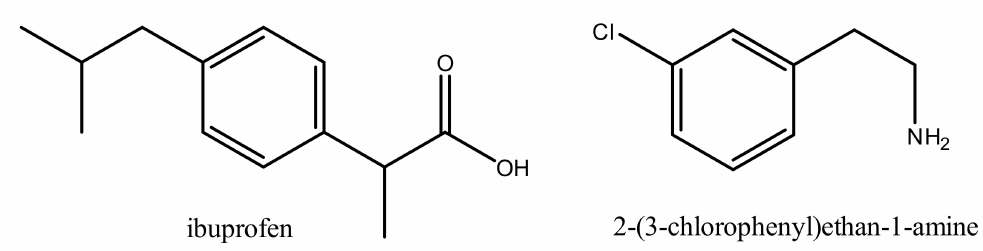
Figure 1. Structural formula of ibuprofen and